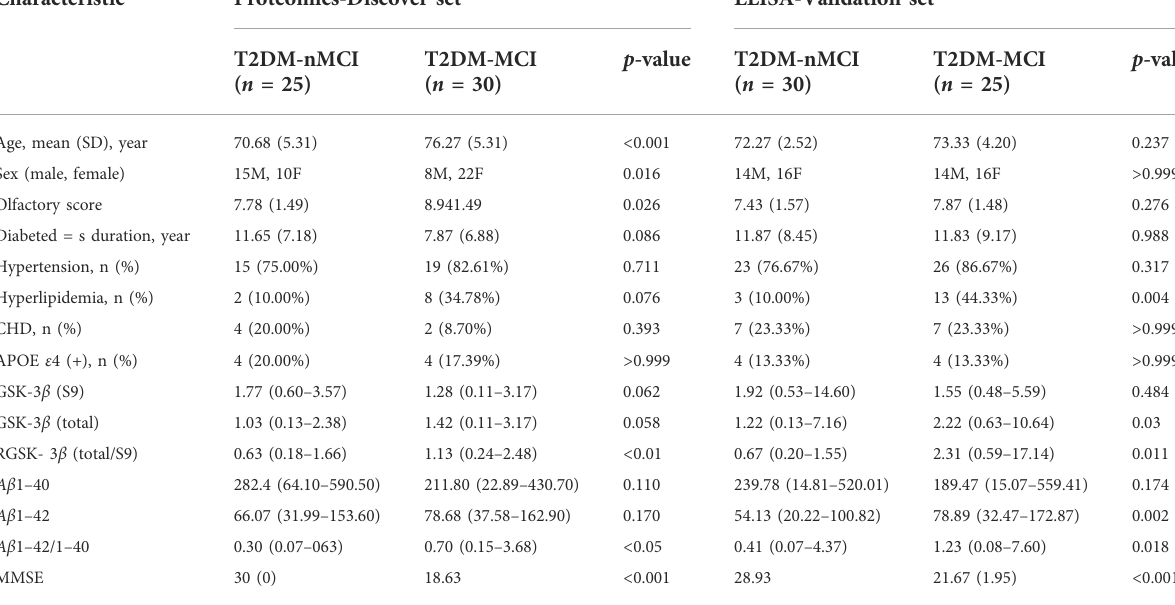
TABLE 1 Information about the T2DM-MCI patients and age-/sex-matched T2DM-nMCI patients. Characteristic